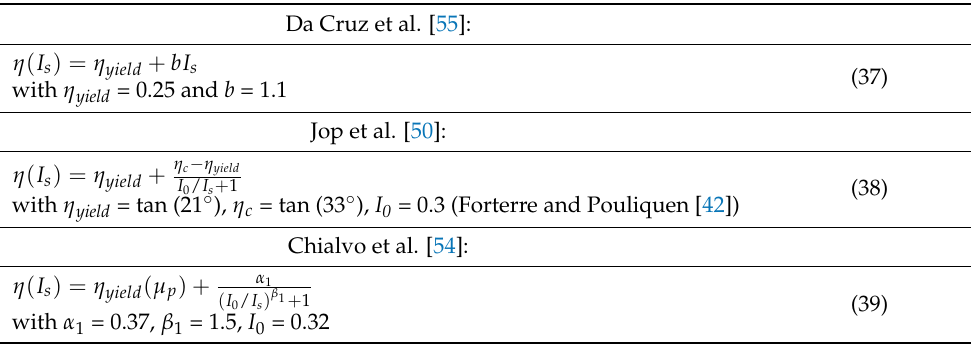
Table 9. Internal friction